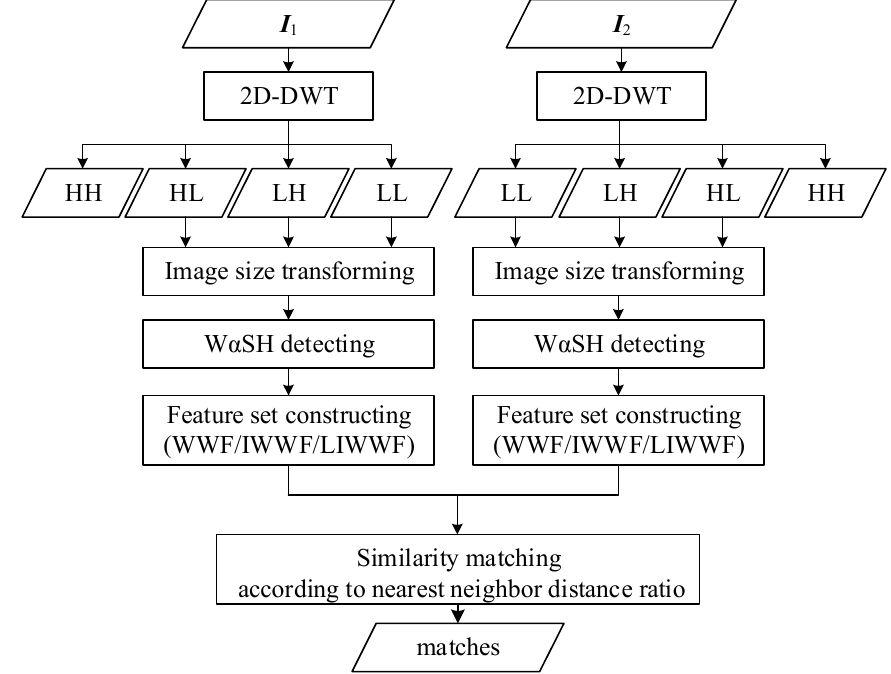
Figure 1. Procedure of improved W α SH feature matching based on 2D-DWT. I 1 and I 2 are the reference image and the image to be matched, respectively.